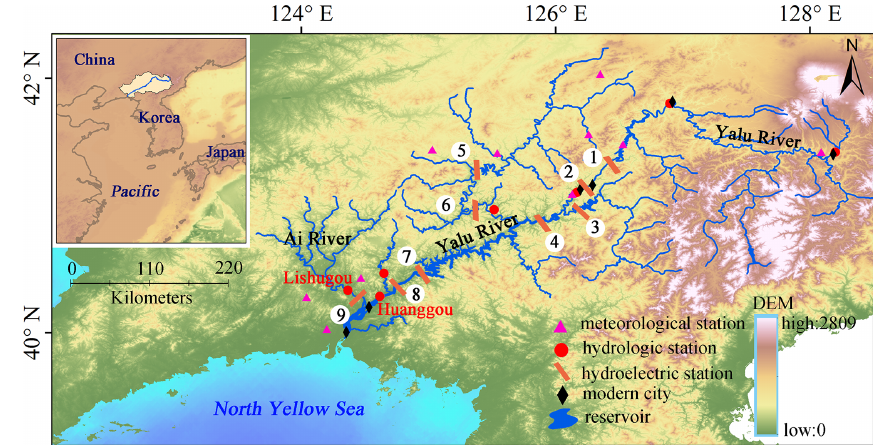
Figure 1. Map of the Yalu River basin. The total water discharge of the Yalu River is the sum of the discharge data recorded in Huanggou and Lishuggou hydrological stations. Numbers 1 to 9 on the map indicate the locations of the reservoirs. Digital elevation model (DEM) data are derived from the ETOPO1 Global Relief Model (https://www.ngdc.noaa.gov/mgg/global/etopo1sources.html, last access: 22 March